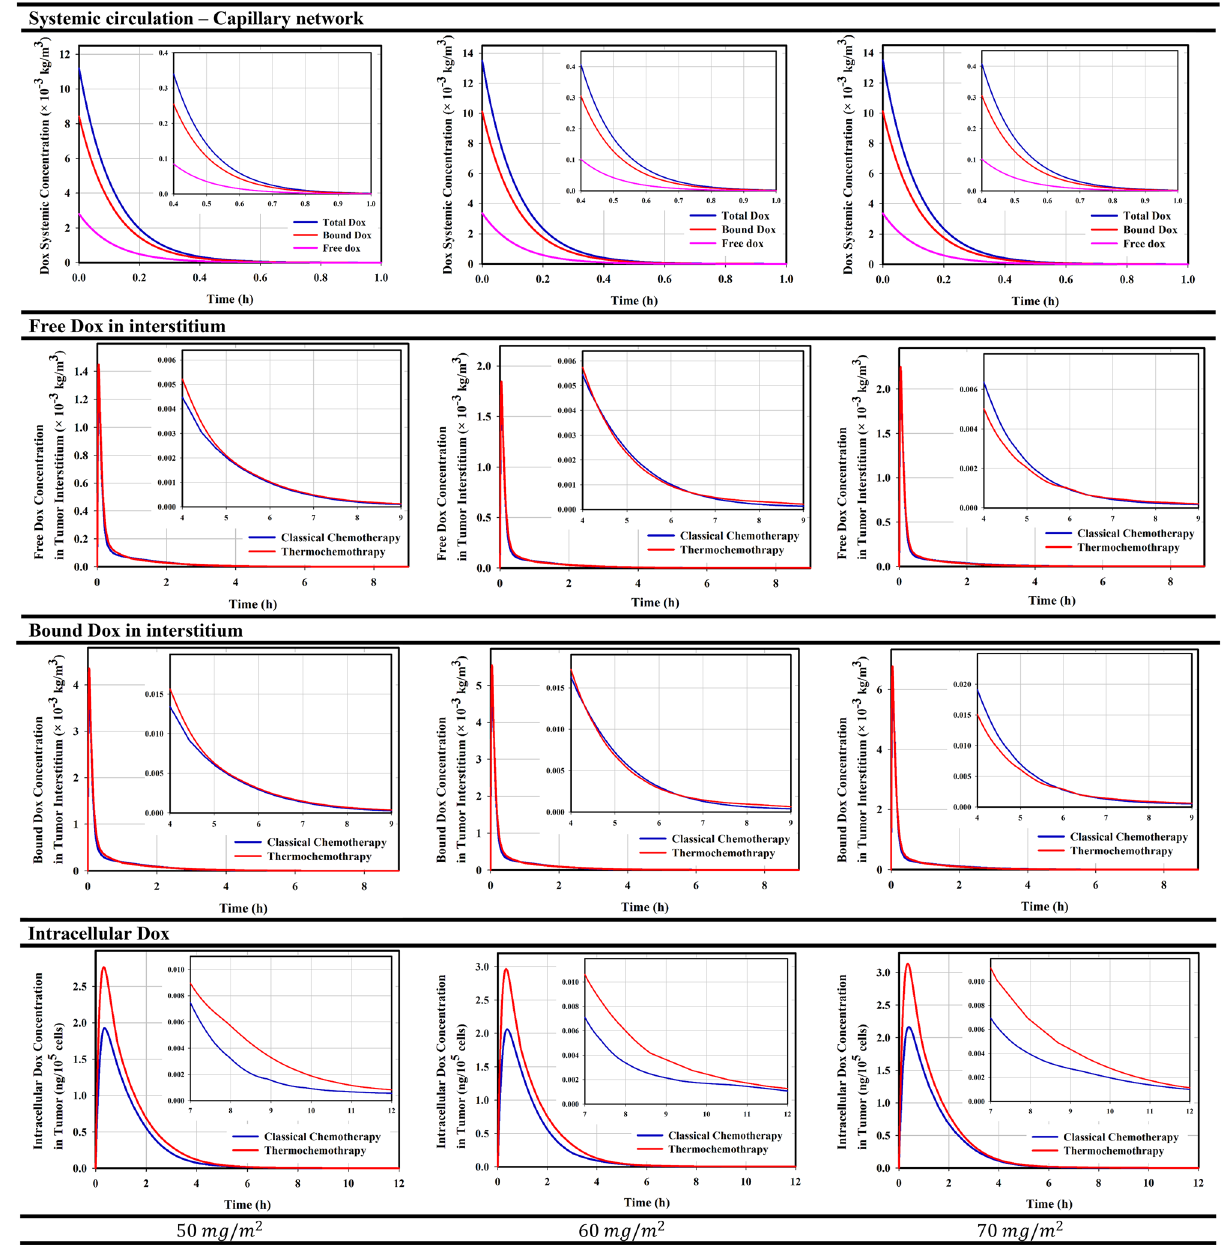
Figure 2. Temporal distribution of drug at different compartments during drug delivery; Increasing the injected dose enhances the concentrations of free and bound drugs at each compartment. Variation of the free and bound drugs in the microvessels depend on the changes in the injected drug. In the extracellular space, the variation of the bound drug is a function of the free drug. The peak intracellular concentration of the drug occurs about 20-min after the peak of free drug in extracellular space due to the time of crossing the transmembrane. The application of hyperthermia causes a change in the concentration of free and bound drug concentrations during drug delivery process due to change in permeability and transmembrane